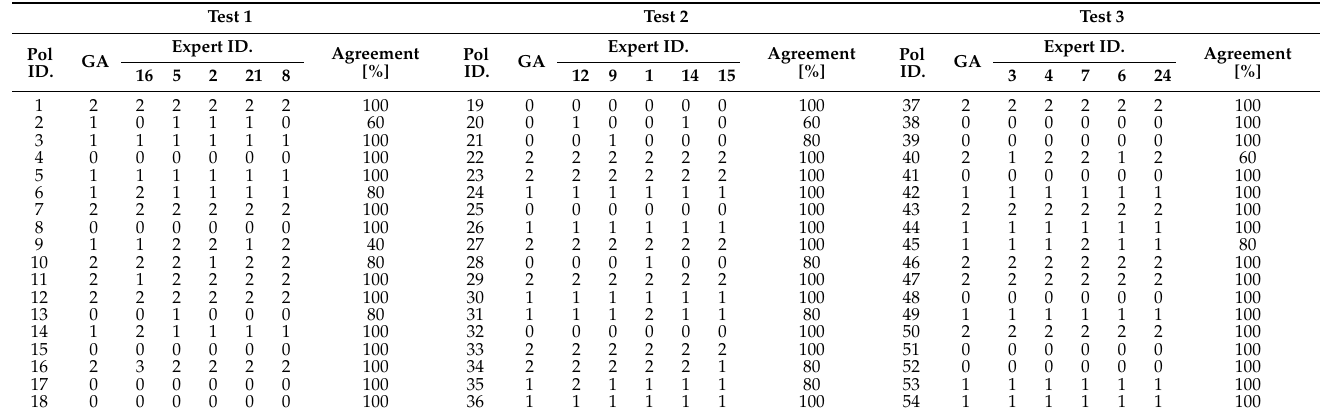
Table A2. Results provided by the experts vs GA. MAV Experiment (Tests 1, 2 and 3).